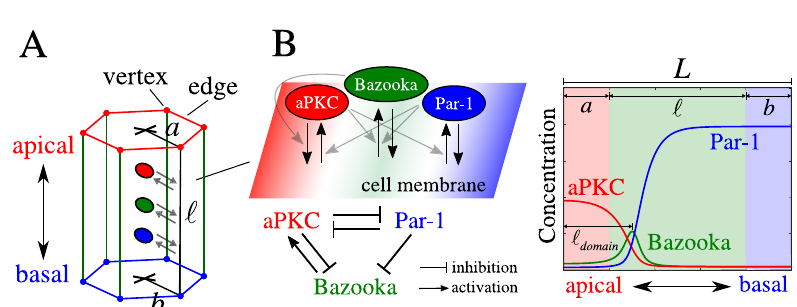
Fig 1. Schematics of the modeled epithelial cell and its polarity network. (A) A hexagonal prism depicting the geometry of the modeled epithelial cell, with its vertices and edges color coded to illustrate their distinct mechanical and biochemical properties. The crosses indicate the start and end points of the apical–basal axis, calculated as the average position of all the apical or basal vertices of the cell. The arrows indicate the exchanges between the cytoplasmic and the membrane pools of the polarity proteins (shown as the color-coded ovals). (B) (Upper left) Enlarged view of the cytoplasm-membrane exchanges depicted in (A). Black arrows denote the association/ dissociation of the polarity proteins to/from the membrane surface. The parallelogram with three distinct color regions for the three domains of the polarity regulators—aPKC, Bazooka, and Par-1—depicts the membrane surface. Grey arrows denote the regulatory interactions among the three polarity regulators that modulate these association/ dissociation exchanges. (Lower left) A diagram for the modeled polarity network with arrows depicting the activation/ inhibition interactions. See Mathematical modeling section for references that reported these interactions. (Right) Schematic representation of a 1D concentration profile along the apical–basal axis for the three polarity network components. The color-coded shades represent the apical, lateral, and basal regions of the cell membrane corresponding to the color-coded edges depicted in (A). See Mathematical modeling section for the definition of a , b and ℓ . Note that the position of adherens junctions on the lateral surfaces corresponds to the location of the maximum Bazooka concentration, as denoted by ℓ domain